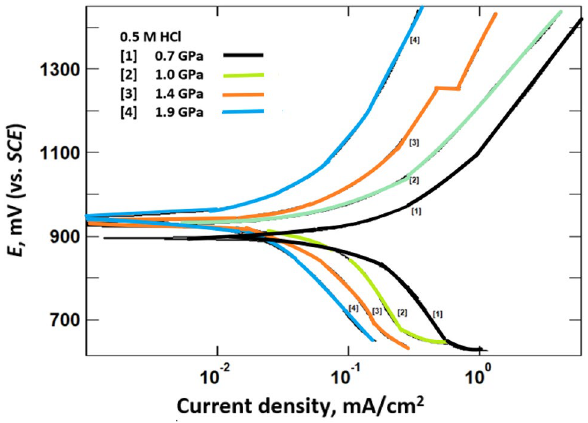
Figure 2. Potentiodynamic polarization curves of (Bi, Pb)-2223 superconductor electrodes compacted at different pressure in 0.5 M